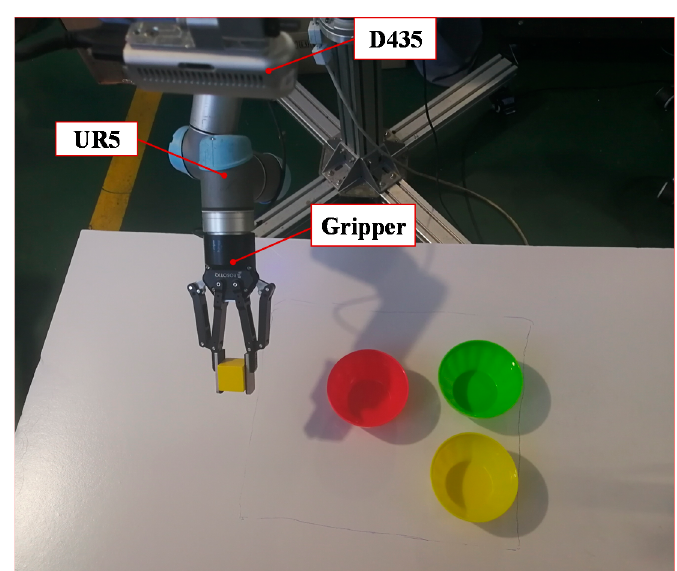
Figure 12. Containers and objects in the real world.